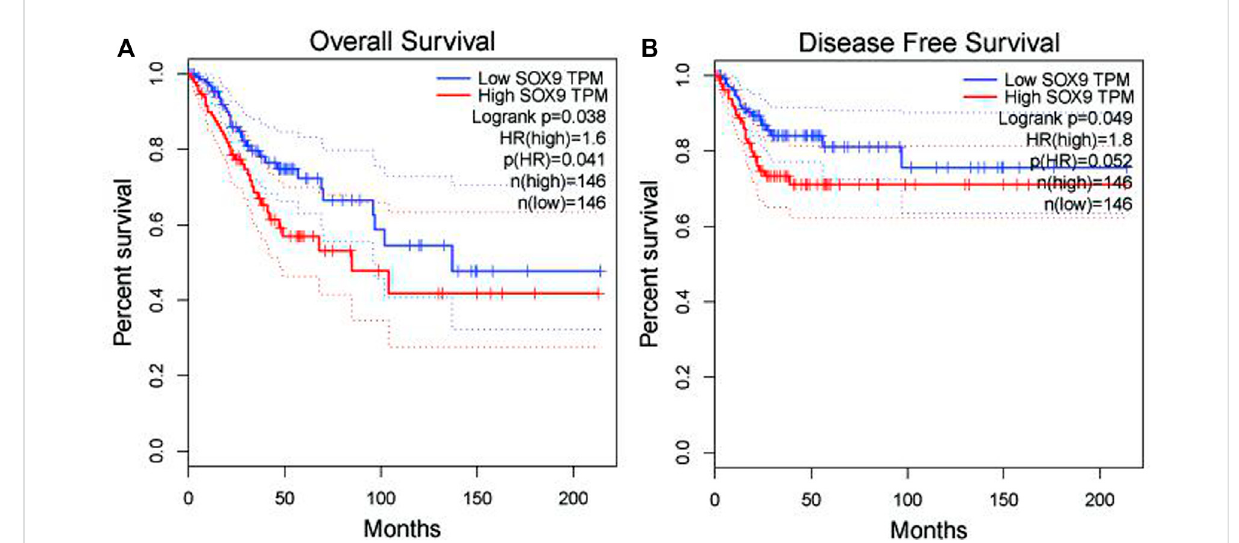
FIGURE 6 Association between SOX9 gene expression and overall survival and disease-free survival of cervical cancer patients in TCGA. (A) Low SOX9 gene expression patient had a high overall survival rate ( p = 0.038). (B) Low SOX9 gene expression patient had a high disease-free survival rate ( p = 0.049). Low expression of SOX9 may lead to higher survival rates and disease-free